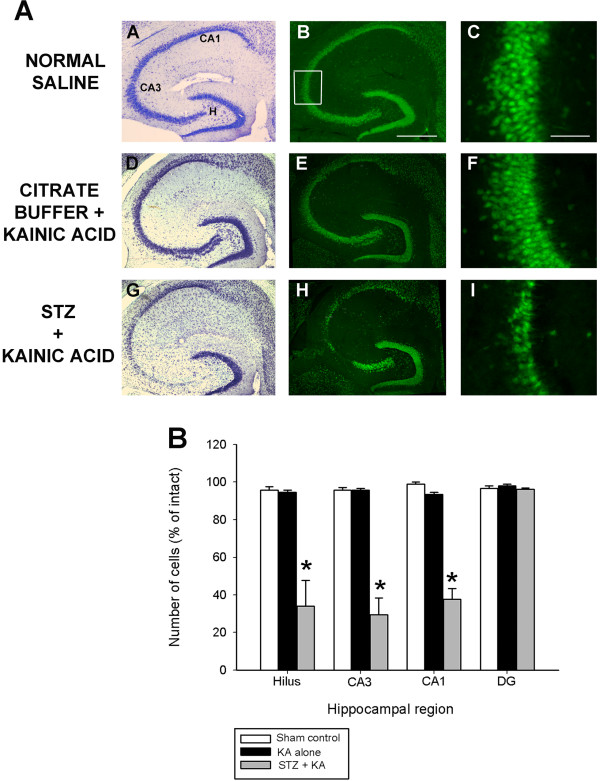
Diabetic-induced hyperglycemia aggravates status epilepticus-induced hippocampal damage. (A) Low-power photomicrographs of cresyl violet (A,D,G) and NeuN-immunofluorescent-stained (B,E,H) horizontal sections of the hippocampus illustrating surviving cells throughout the hippocampus 7 days following systemic kainate administration to vehicle-treated, and STZ-treated mice that underwent KA-induced SE. STZ-induced hyperglycemia dramatically increased the extent of hippocampal cell death in excitotoxin cell death resistant B6 mice. Note the significant amount of cell damage in representative sections from STZ + KA treated mice as evidenced by a loss of cresyl violet staining (G) and NeuN-immunofluorescence (H) and complete absence of any seizure-associated cell loss in KA treated mice (D,E). CA1 and CA3 denote the hippocampal subfields; H, dentate hilus. Scale bar = 750 μm (A,C); 100 μm (B,D). High-magnification photomicrographs represent details of the boxed area of CA3 shown in B. (B) Quantitative analysis of neuronal density in hippocampal subfields seven days following STZ + KA administration to B6 mice. Viable surviving neurons were estimated by cresyl violet staining. Bars denote the percentage of surviving neurons (as compared with saline-injected sham control B6 mice). Data represent the mean ± S.E.M. of at least 5 mice per condition. Asterisks indicate significant difference compared with KA alone or Sham control of P<0.05. (ANOVA with post hoc Student Newman Keuls; F=195.54, P<0.001).